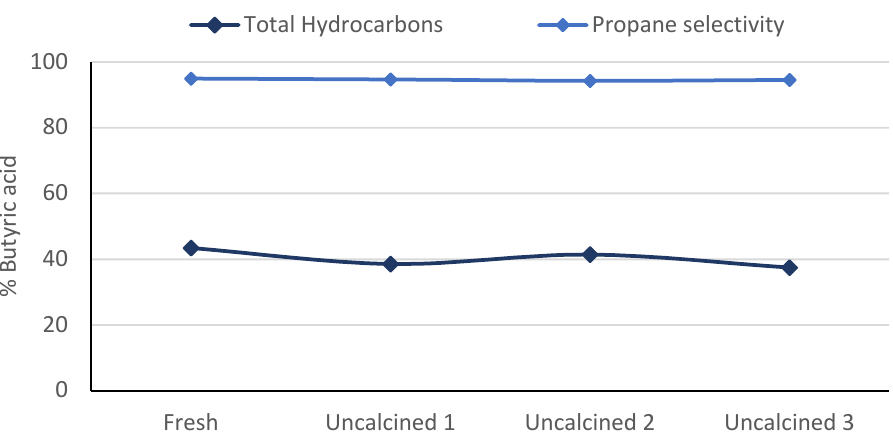
Figure 8. Reusability of catalyst with a 1:1 mass ratio of butyric acid to bulk Pt/C at 300 °C for 1 h.